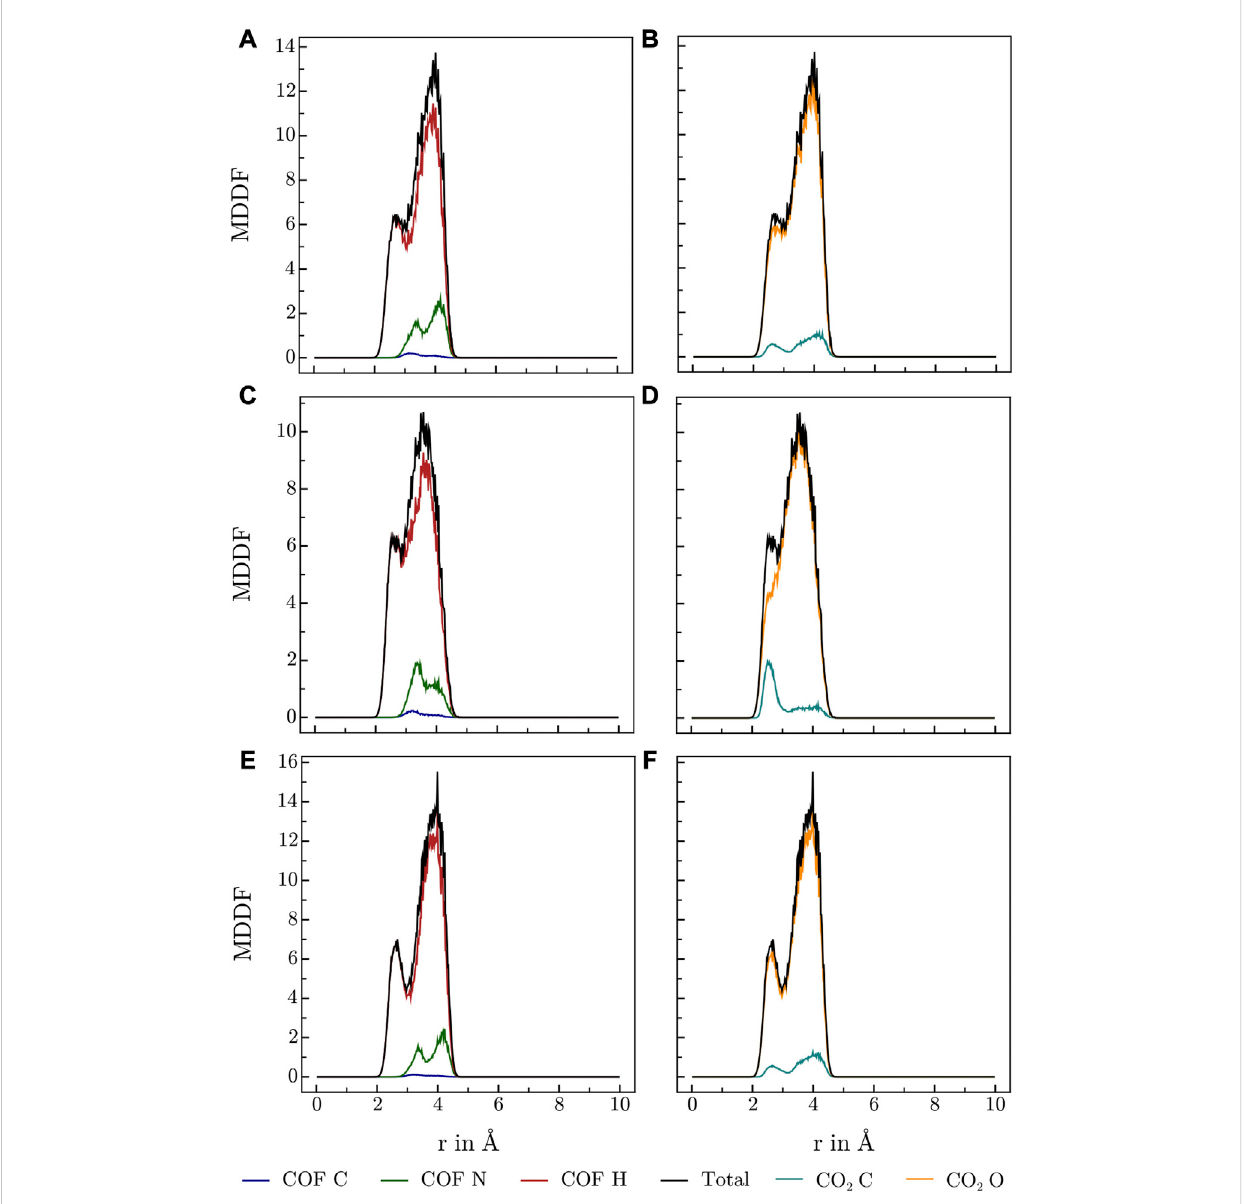
FIGURE 5 MDDFs obtained for HEX-COF1 at various conditions, (A, B) 273.15 K and high CO 2 concentrations (8 CO 2 /pore), (C, D) 273.15 K and low CO 2 concentrations (2